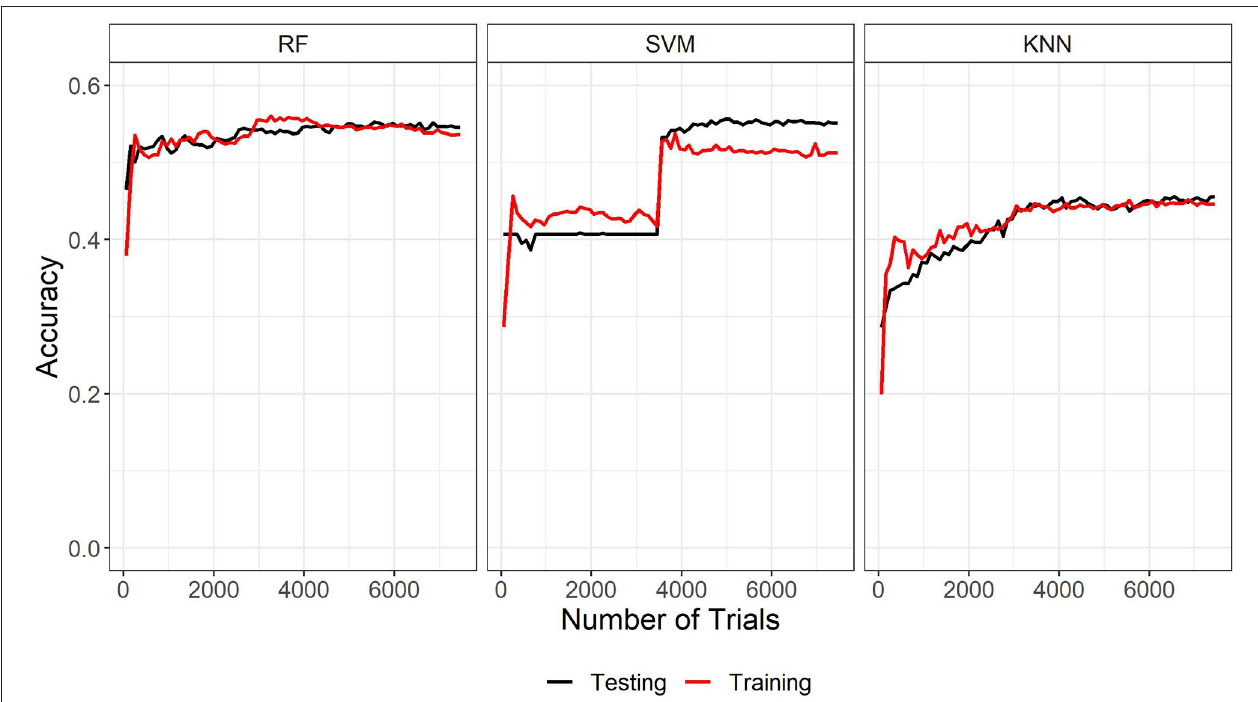
FIGURE 3 | Learning curves of the three machine learning algorithms trained on the left ear data. RF, Random Forest; SVM, Support vector machines with radial kernel; KNN, k-nearest neighbors. TABLE 4 | Confusion matrix results of left ear machine learning predictions.